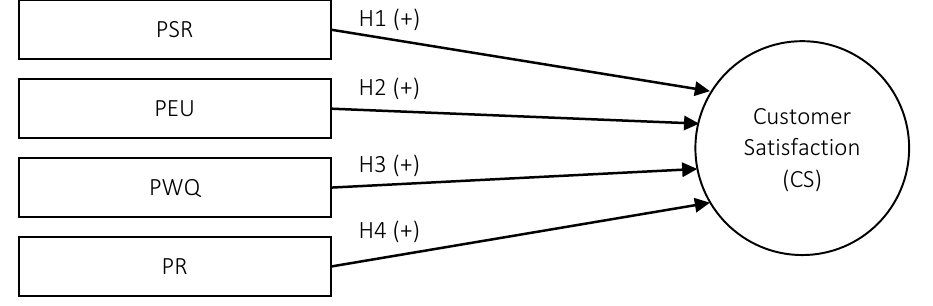
Figure 1. Investigation